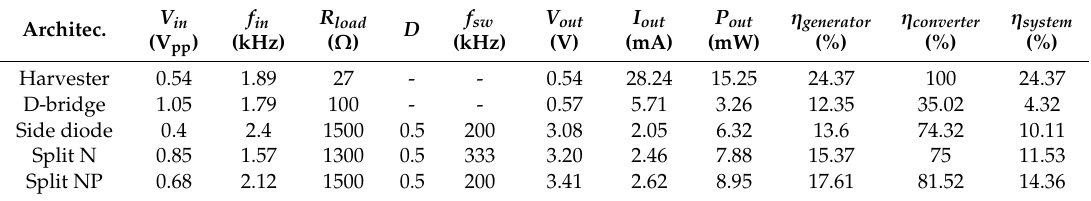
Table 23. Converters’ best results with the minimum input value: 3 m / s. Architec.